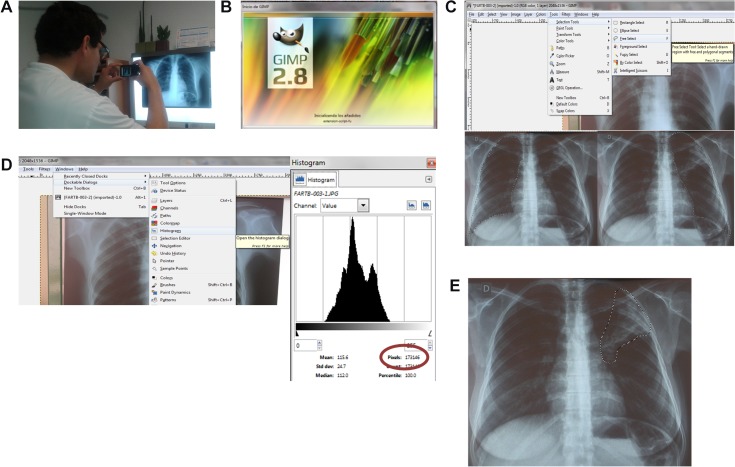
Flowchart of the followed methodology.A. Health worker taking a photo of a radiograph. B. Opening JPEG files with GIMP software. C. Selection of the area. D. Pixel quantification. E. Selected “affected area.”